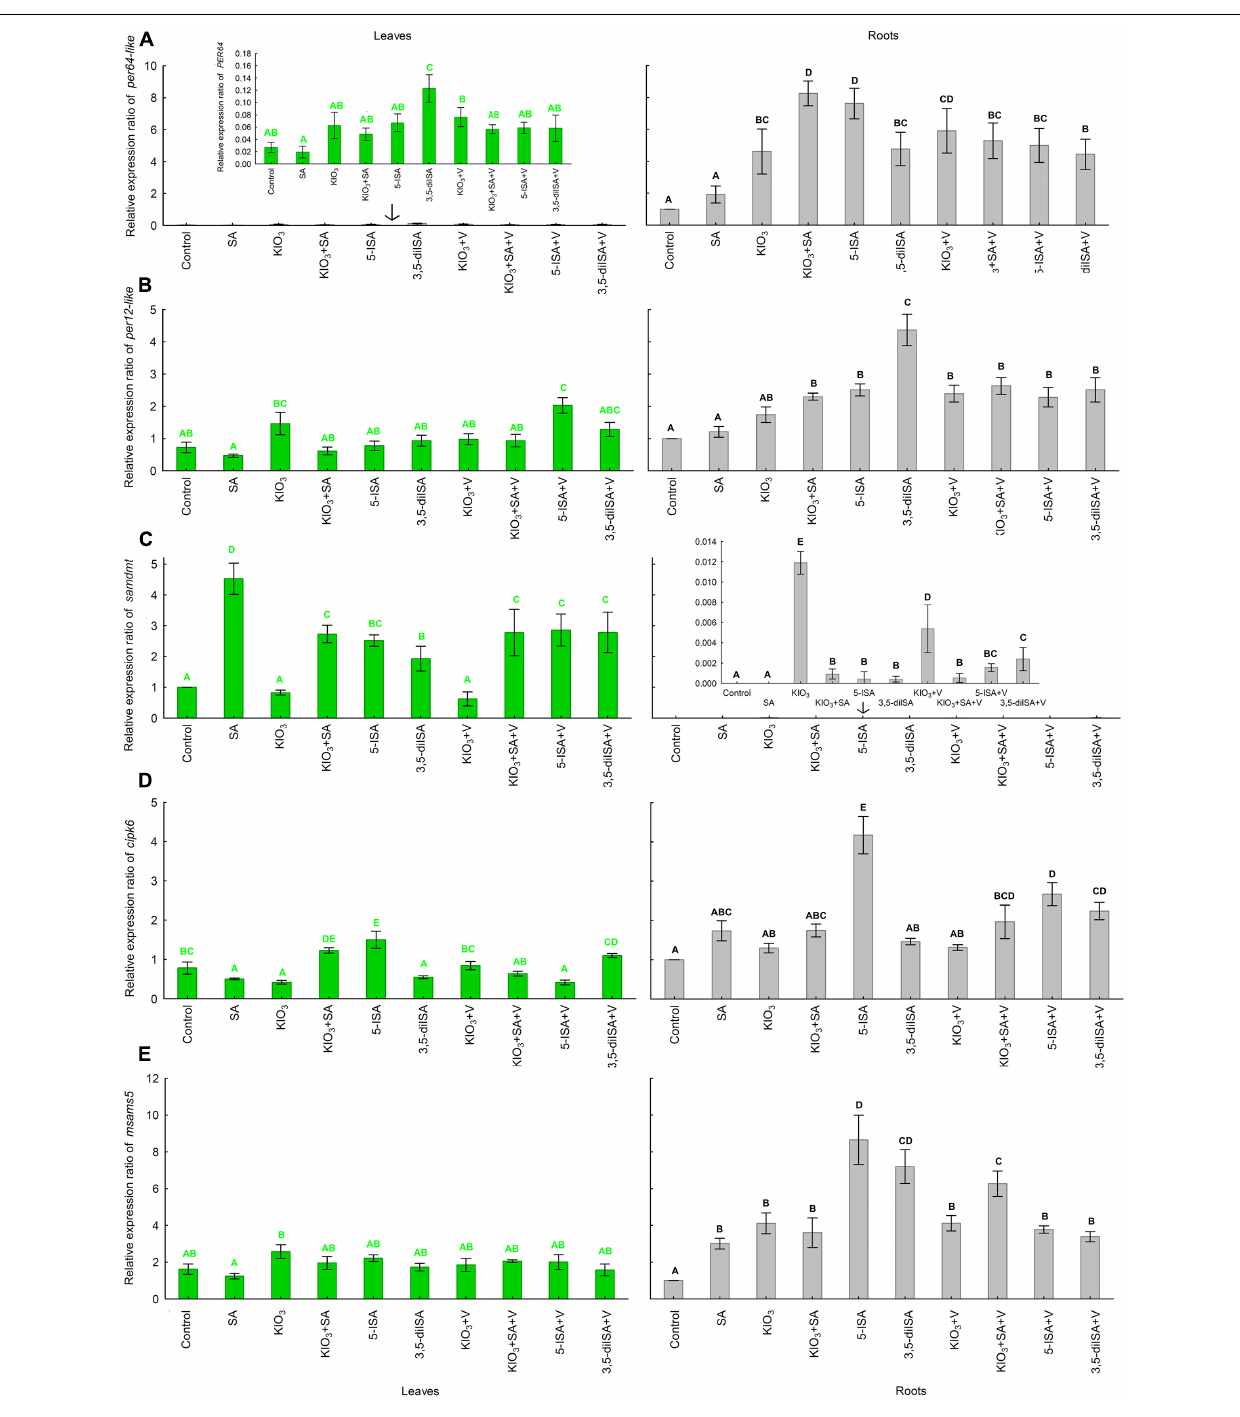
a single lettuce head was significantly lowered for 5- ISA+V vs. 5-ISA in both pot experiments ( Supplementary Tables 2 , 3